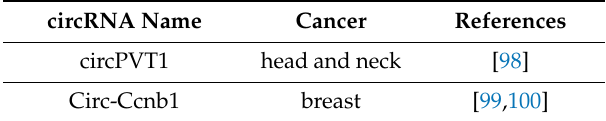
Table 4. Circular RNAs regulated by Gain of Function